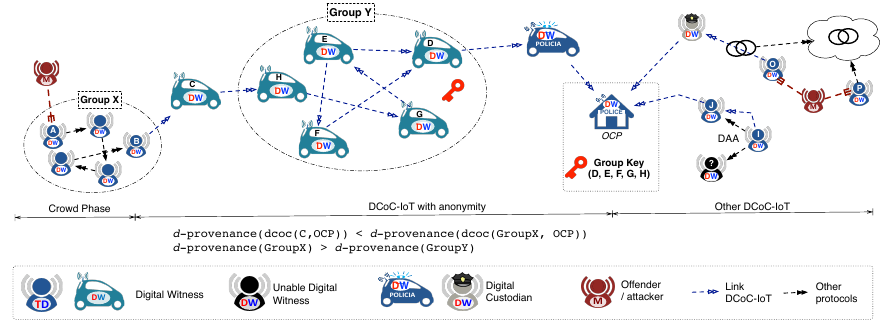
Figure 4. Anonymous digital